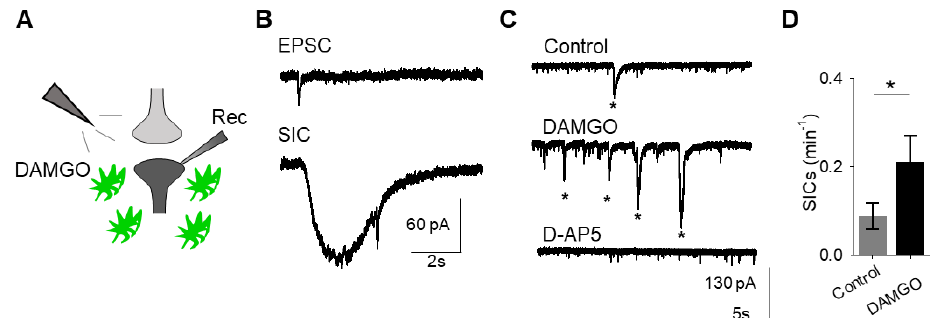
Figure 2. µ -Opioid receptor activation evokes slow inward currents in neurons. ( A ) Scheme of electrophysiology experimental approach illustrating local application of DAMGO to the nucleus accumbens and recording of nucleus accumbens medium spiny neurons. ( B ) Representative traces of excitatory post-synaptic potential (EPSC; top) and slow inward current (SIC; bottom). ( C ) Representative electrophysiology recordings in control conditions (top), after DAMGO application (middle), and in the presence of the D-AP5 (bottom). Stars indicate SICs. ( D ) SICs per minute before (control) and after DAMGO application. Data are expressed as mean ± SEM, * p < 0.05. To confirm that the effects of DAMGO were mediated by the activation of opioid receptors, we conducted experiments in the presence of the global opioid receptor antagonist naltrexone (10 µM). We found that in the presence of naltrexone, DAMGO no longer induced astrocytic calcium elevations ( n = 55 astrocytes from n = 7 experimental planes of view, p = 0.77; Figure 3A – C; Table 3) nor affected neuronal SICs ( n = 5, p = 0.62; Figure 3D – F; Table 3), suggesting that DAMGO actions are